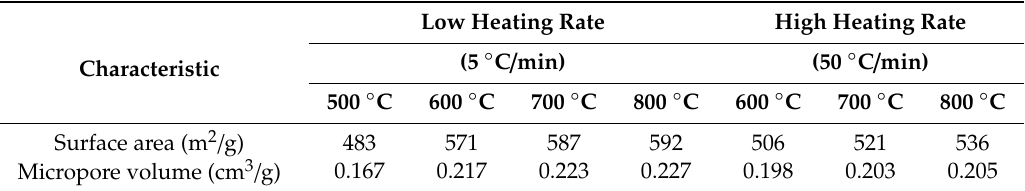
Table 5. The temperature e ff ect on the physical properties of the biochar (surface area and micropore volume) for walnut shell pyrolysis at a low heating rate (5 ◦ C / min) and high heating rate (50 ◦ C / min) and moisture content 7.85 wt.%, at 800 ◦